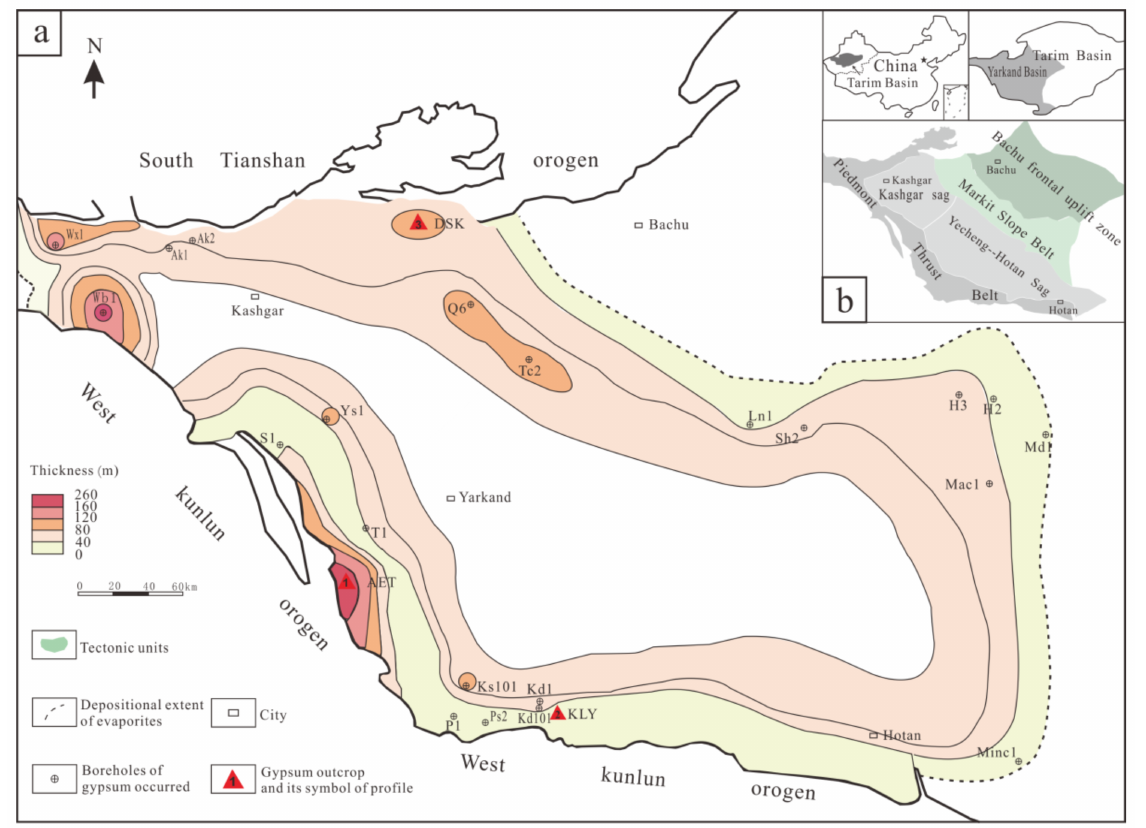
Figure 1. ( a ) Isopach map of gypsum, gypsum outcrops, boreholes of gypsum occurred in